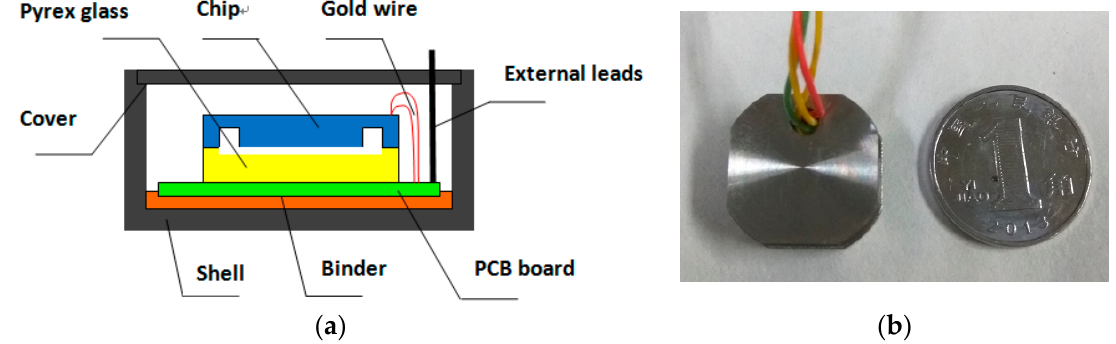
Figure 14. The schematic of the packaging and the photo of the packaged sensor. ( a ) The schematic of